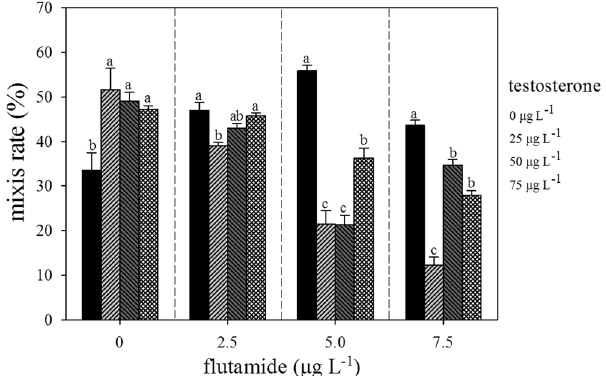
Figure 2. Effects of testosterone and flutamide on the mixis rate (MR) at 4 d in B. calyciflorus (n = 5).